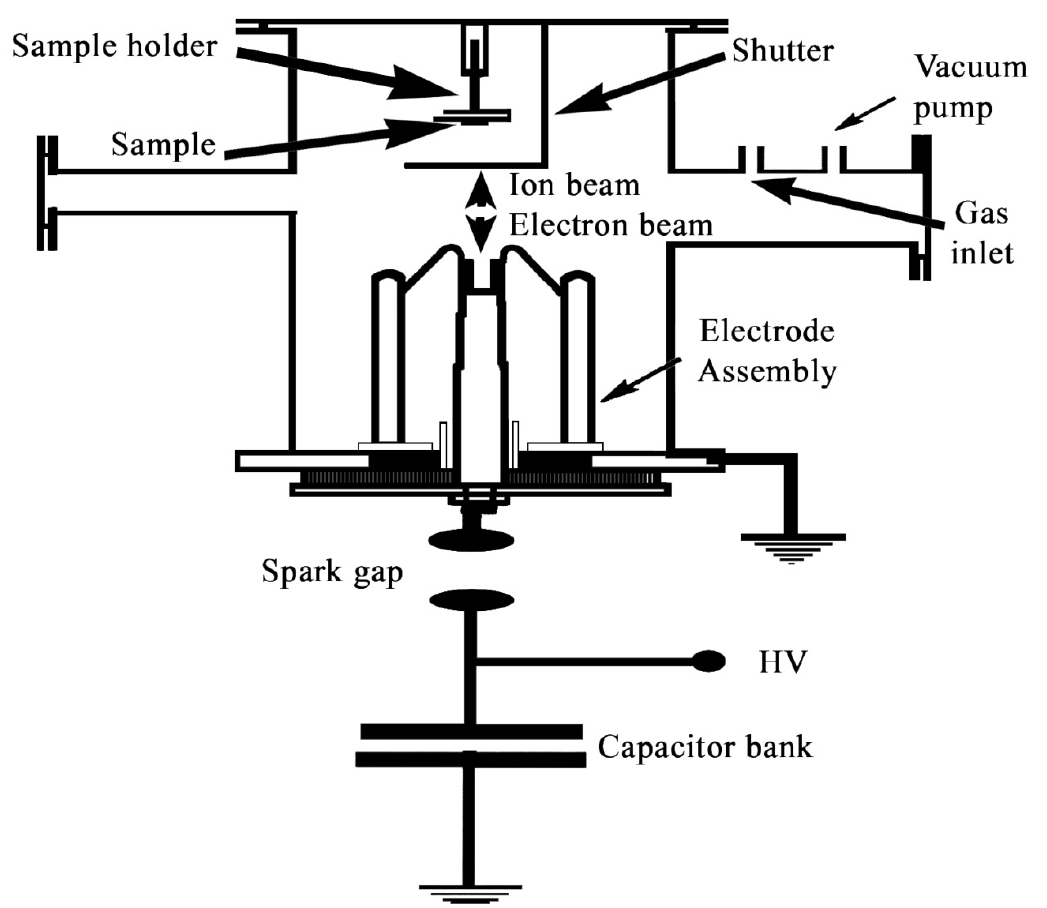
Figure 1. Schematic arrangement of Mather type plasma focus used for ion plasma coating of samples. Reprinted from reference [23] with permission from Elsevier.